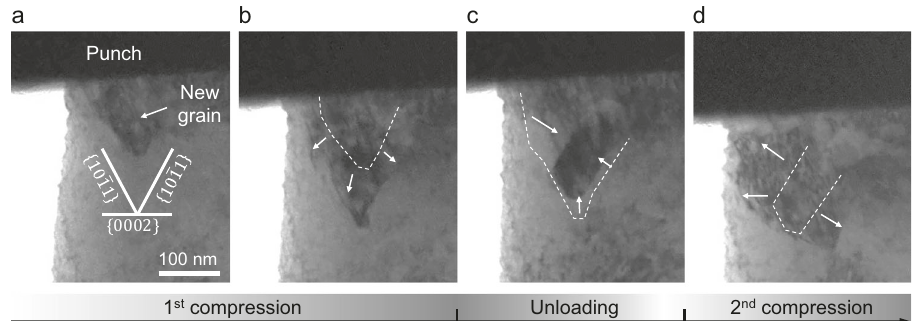
Fig. 3 The growth and shrinking of a new grain. This grain formed when the stress reached ~1.0 GPa at the end of Stage-1, near the contact interface between the pillar top and diamond punch. a , b It grew during loading, c shrank during unloading, d then grew again upon reloading. Dashed line marks the previous position of the boundary. The viewing direction is (cid:2)h 2 (cid:1) 1 (cid:1) 10 i . The traces of f 0002 g and f 10 (cid:1) 11 g are